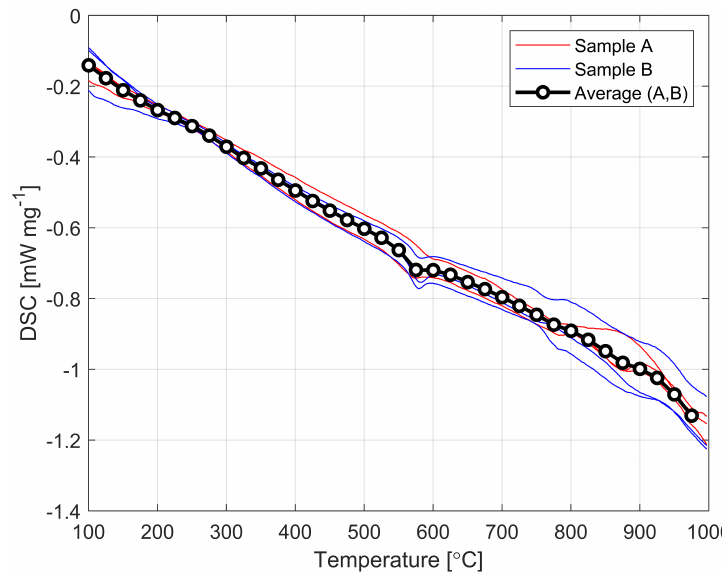
Figure 4. DSC graph for two sets of